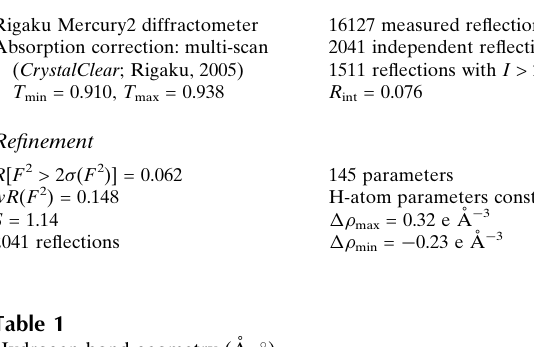
Hydrogen-bond geometry (A˚ , (cid:4)